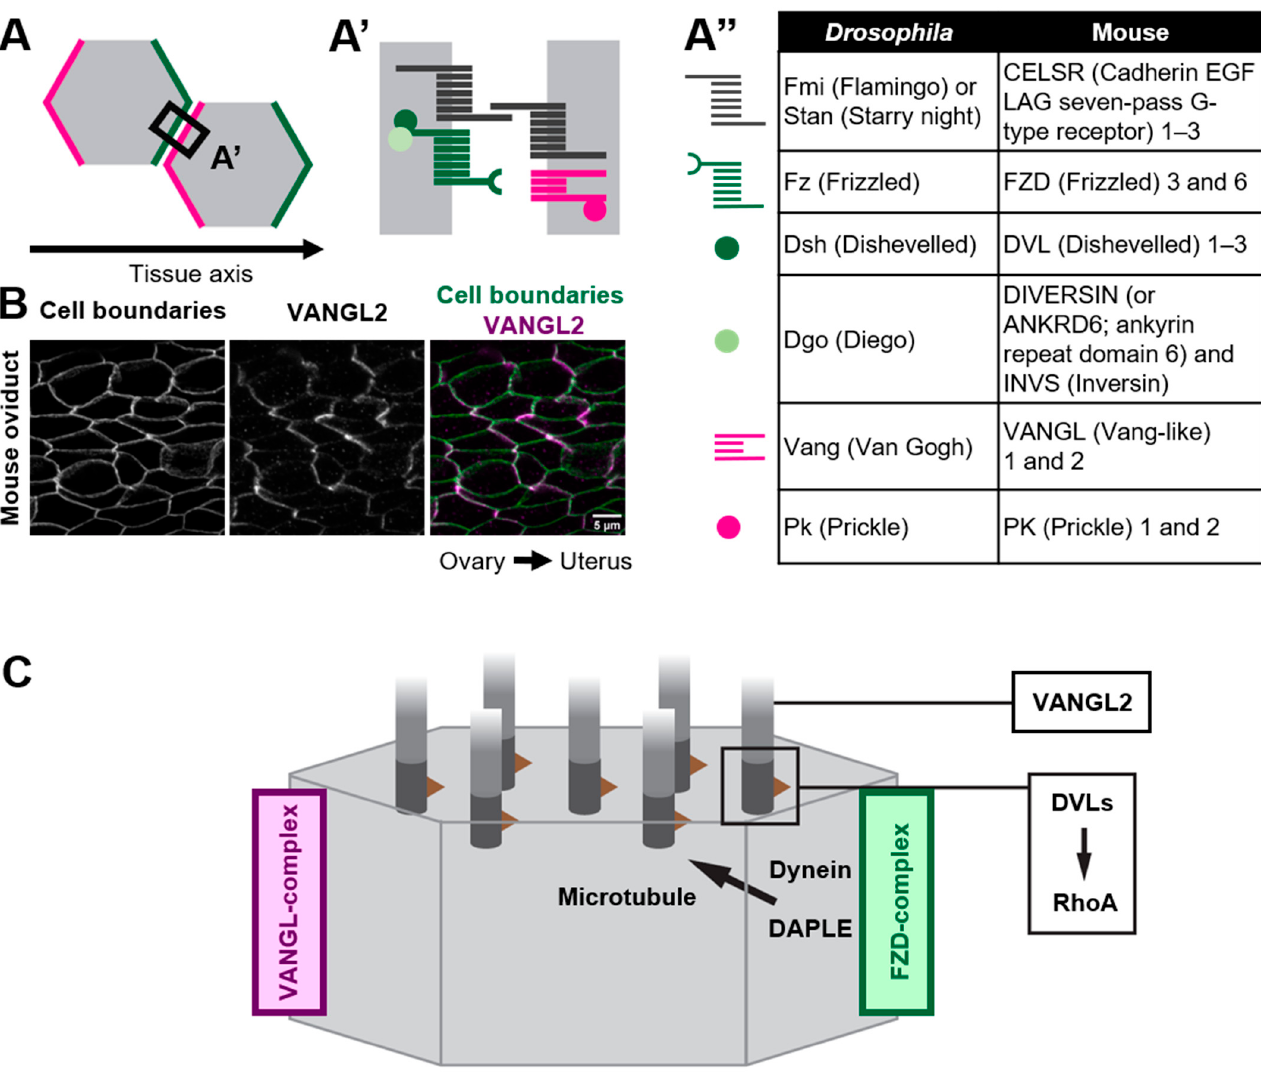
Figure 2. Polarized distribution of core PCP proteins along the tissue axis. ( A – A” ) Core PCP proteins form an asymmetric complex at cell boundaries. ( A , A’ ) FZD-containing complex (FZD-complex; green) and VANGL-containing complex (VANGL-complex; magenta) are segregated to opposite cell boundaries (note that their distribution is polarized along the tissue axis). Extracellular domain of CELSRs provides intercellular bridges between the FZD-complex and the VANGL-complex, thus enabling the coupling of cell polarity at a multicellular level. ( A” ) A list of members of core PCP proteins in Drosophila and their counterparts in mice. ( B ) Mouse oviduct epithelium was stained for E-cadherin and a core PCP protein, VANGL2. E-cadherin labels cell boundaries. Note the zigzag pattern of VANGL2 signals which highlights polarity in the cell-boundary distribution of VANGL2 along the ovary–uterus axis. ( C ) Mechanisms by which core PCP proteins control the coordinated movements of cilia.